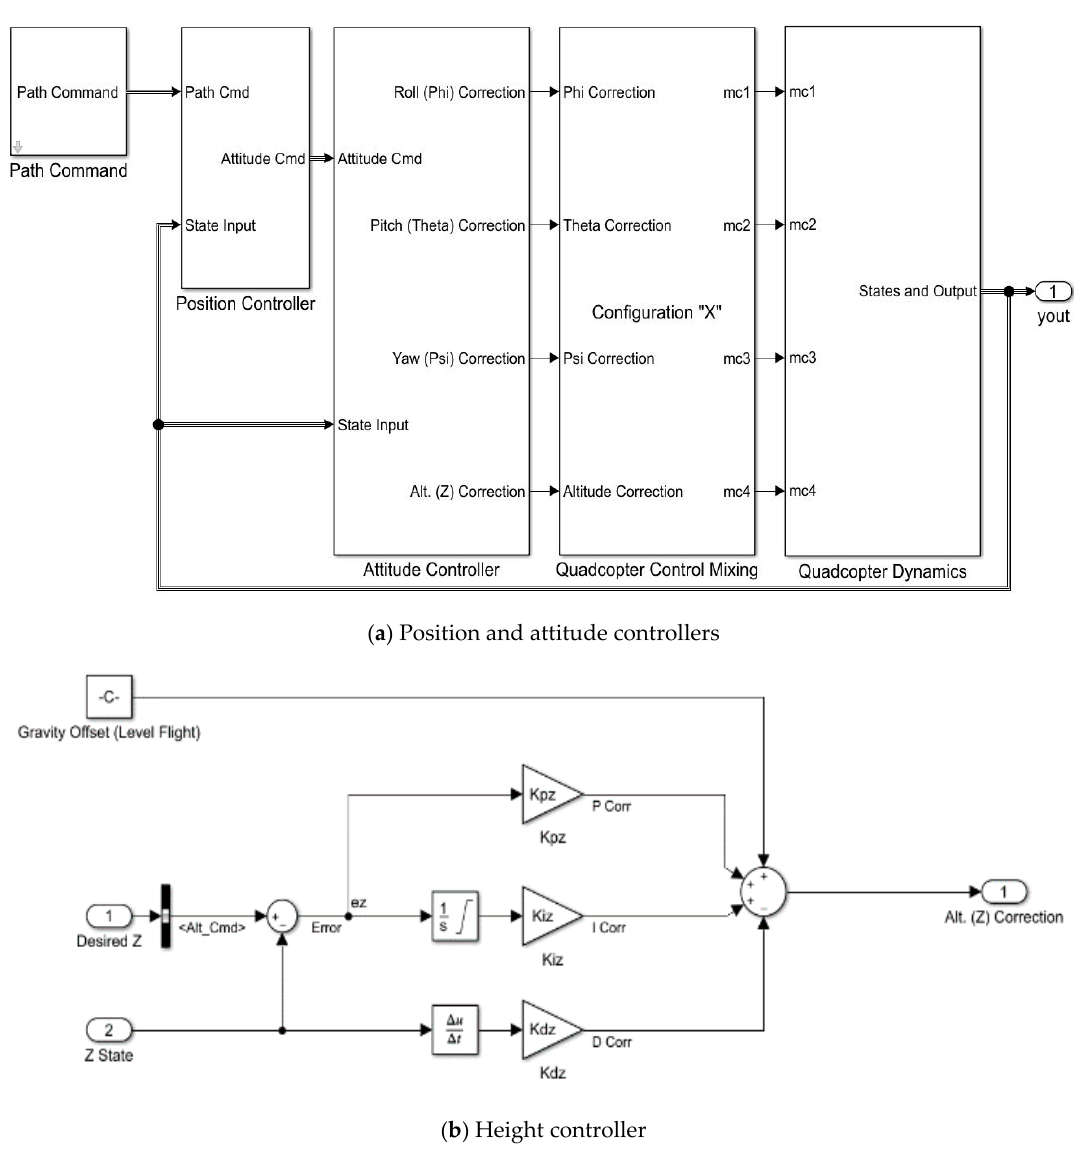
Figure 5. Simulink structures of the integrated control of the autonomous quadrotor.